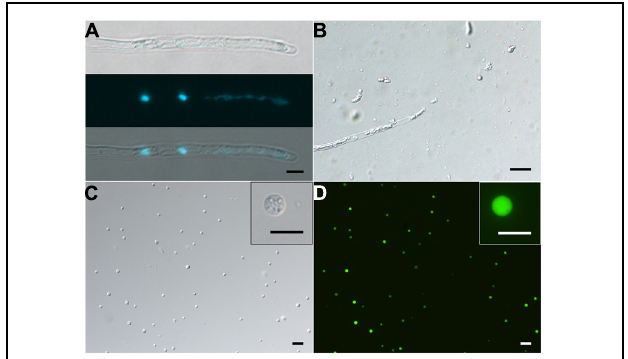
FIGURE 4 | Isolation of SCs from 10-h–cultured pollen tubes. (A) DIC (upper) and DAPI staining (middle) and merged (bottom) images of pollen tube. (B) Representative enzymolysis-treated pollen tubes. (C,D) DIC microscopy (C) and viability of purified SCs with FDA staining (D) . The inset images in (C) and (D) are close-ups of the SC. Scale bar: 20 μ m in (A) to (D) , 10 μ m in inset images of (C) and (D) .